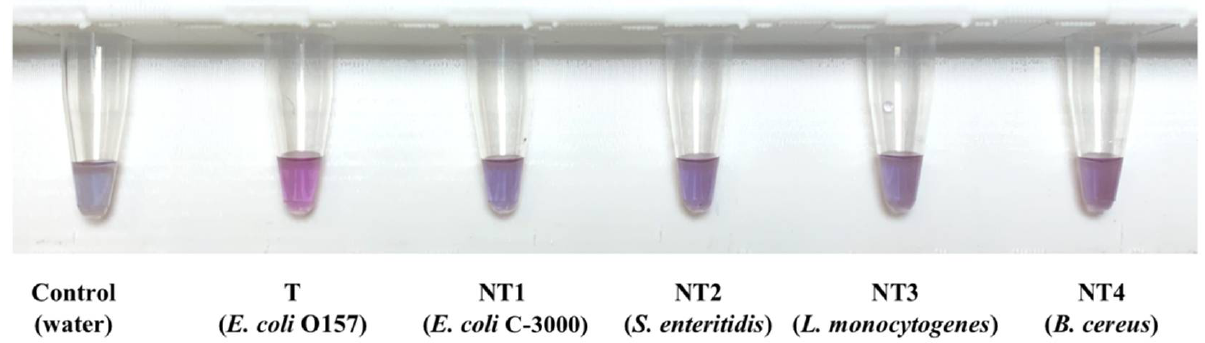
Figure 4. Visual results for one specificity trial using specific E. coli O157 biosensor.